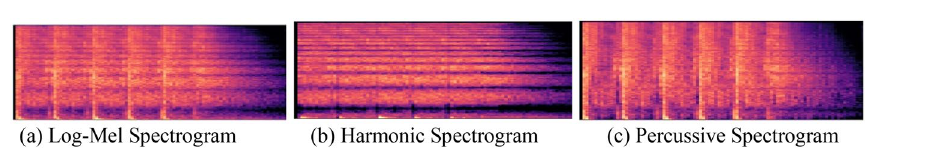
Figure 4. Harmonic Spectrograms and Percussive Spectrograms separated from the Log-Mel Spectrogram of the gunshot category using the HPSS